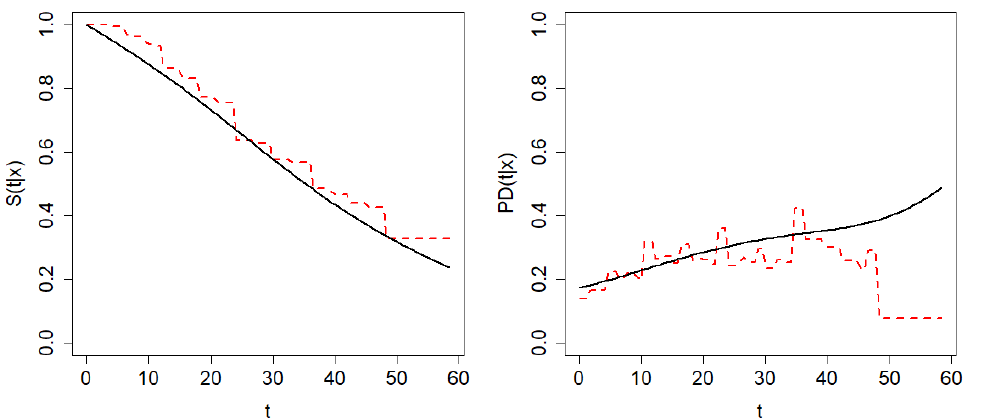
Figure 12. Conditional survival function estimation ( left ) and probability of default estimation ( right ) by means of Beran’s estimator (dashed line) and the smoothed Beran’s estimator (solid line) with bootstrap bandwidths when x = 0.85 in the German credit dataset.